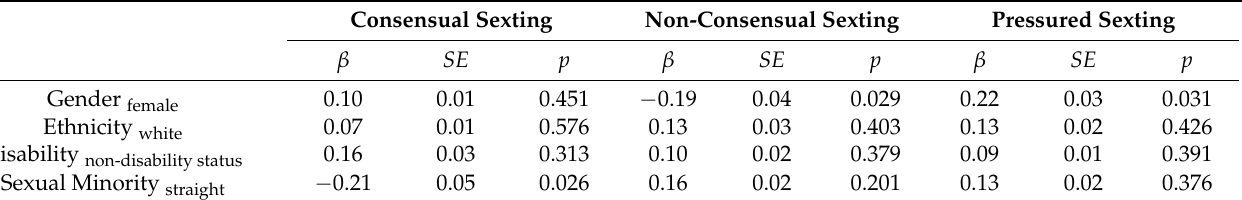
Table 3. Structural regression model